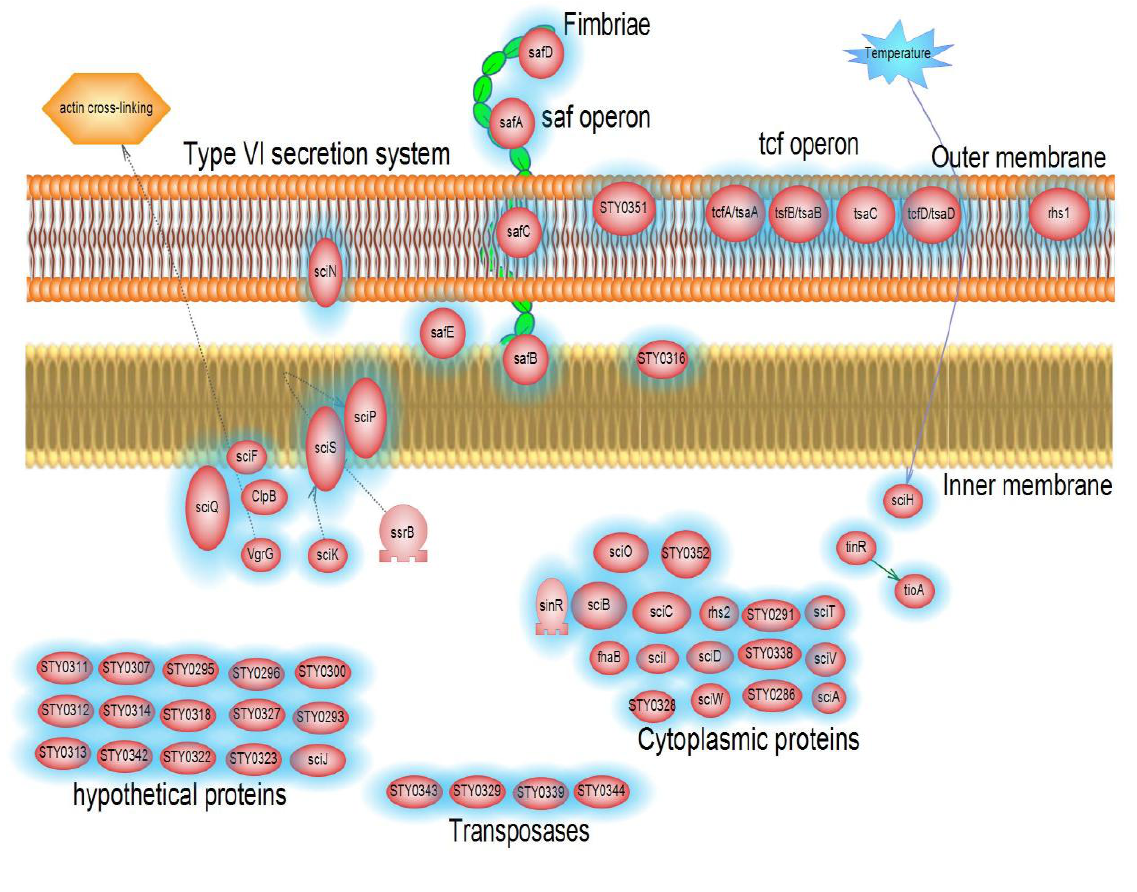
Figure 7: SPI-6 proteins shown in pathway diagram form. The function and regulation of the genes encoded in SPI-6 are still mainly unknown. Here we show only sub-cellular localization and function predicted for 44 genes from SPI-6 revealed by our sequence analysis. A detailed view of the SPI-5 pathway including supporting literature is available at